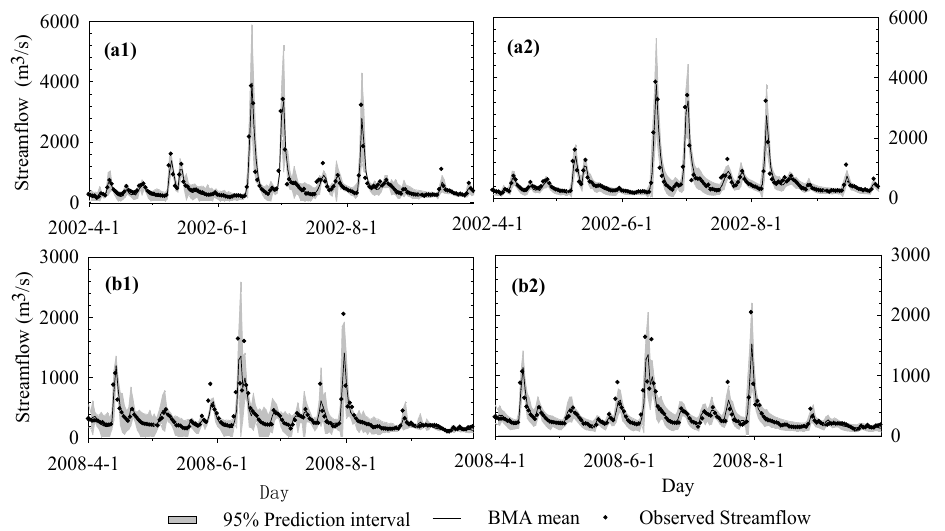
Fig. 3 The BMA combined streamflow series and the 95% confidence interval from the SCE-UA (left) and SCEM-UA (right) based simulations. Note: For the SCE-UA, we use a Markov chain Monte Carlo sampling method ( sampling 1000 times) to calculate the prediction interval (Duan et al ., 2007). Table 2 The reliability performance of the calculated 95% confidence interval at different simulation cases.